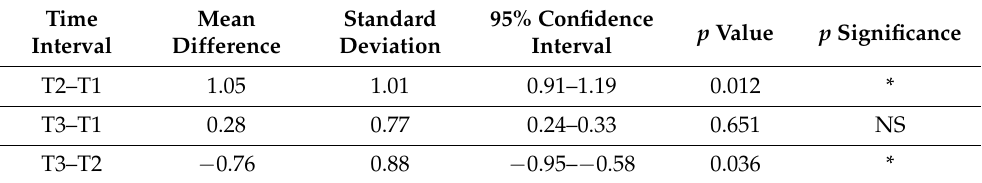
Table 6. Results of the mean differences (mm) of Nasal Width 4 in the three time intervals.